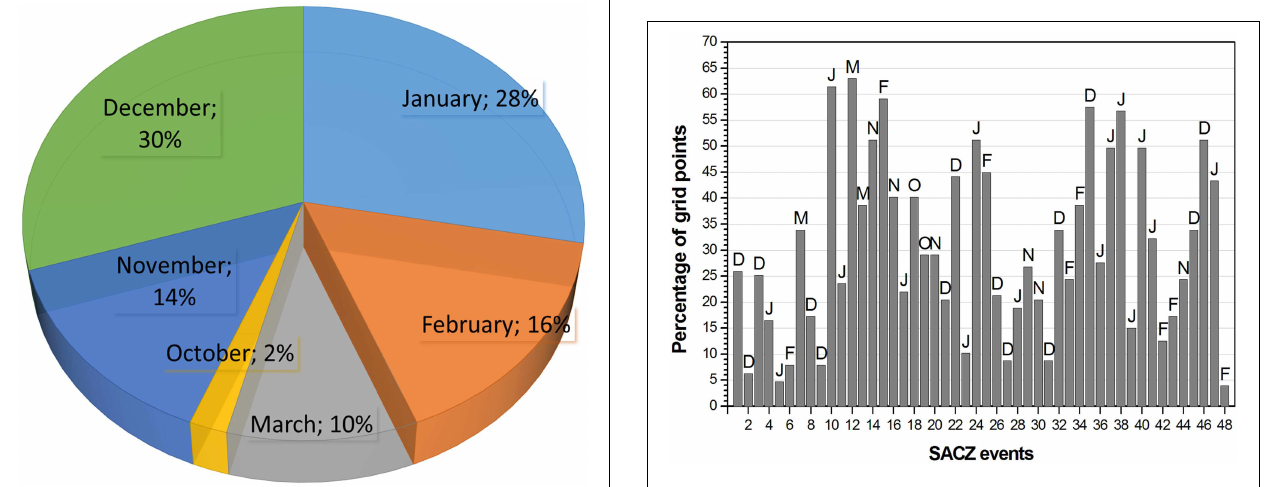
FIGURE 3 | Percentage of grid points where SACZ events happened when considered the period from October to